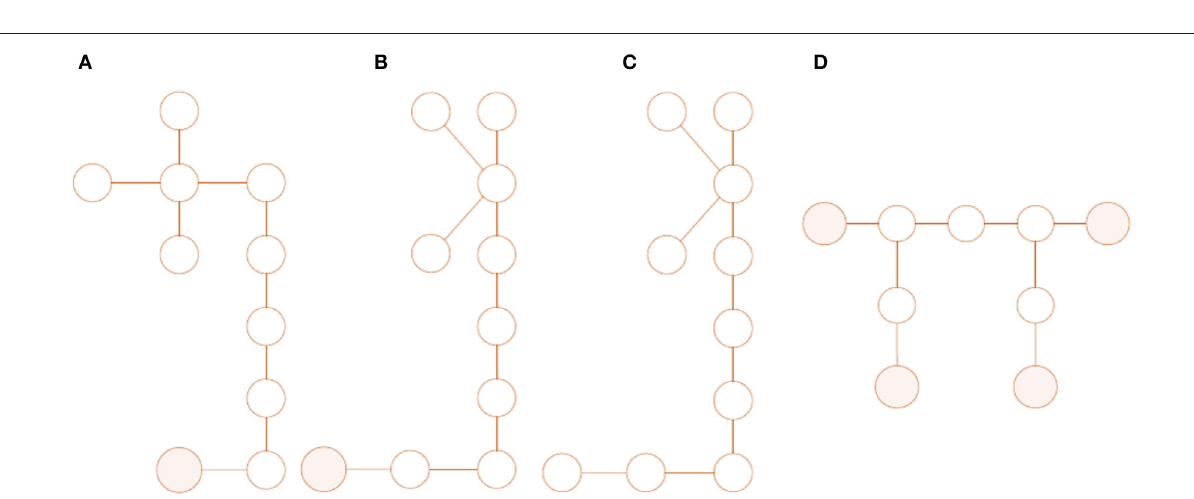
A classifier in the latent space which correctly separates the source data, will also correctly identify the target